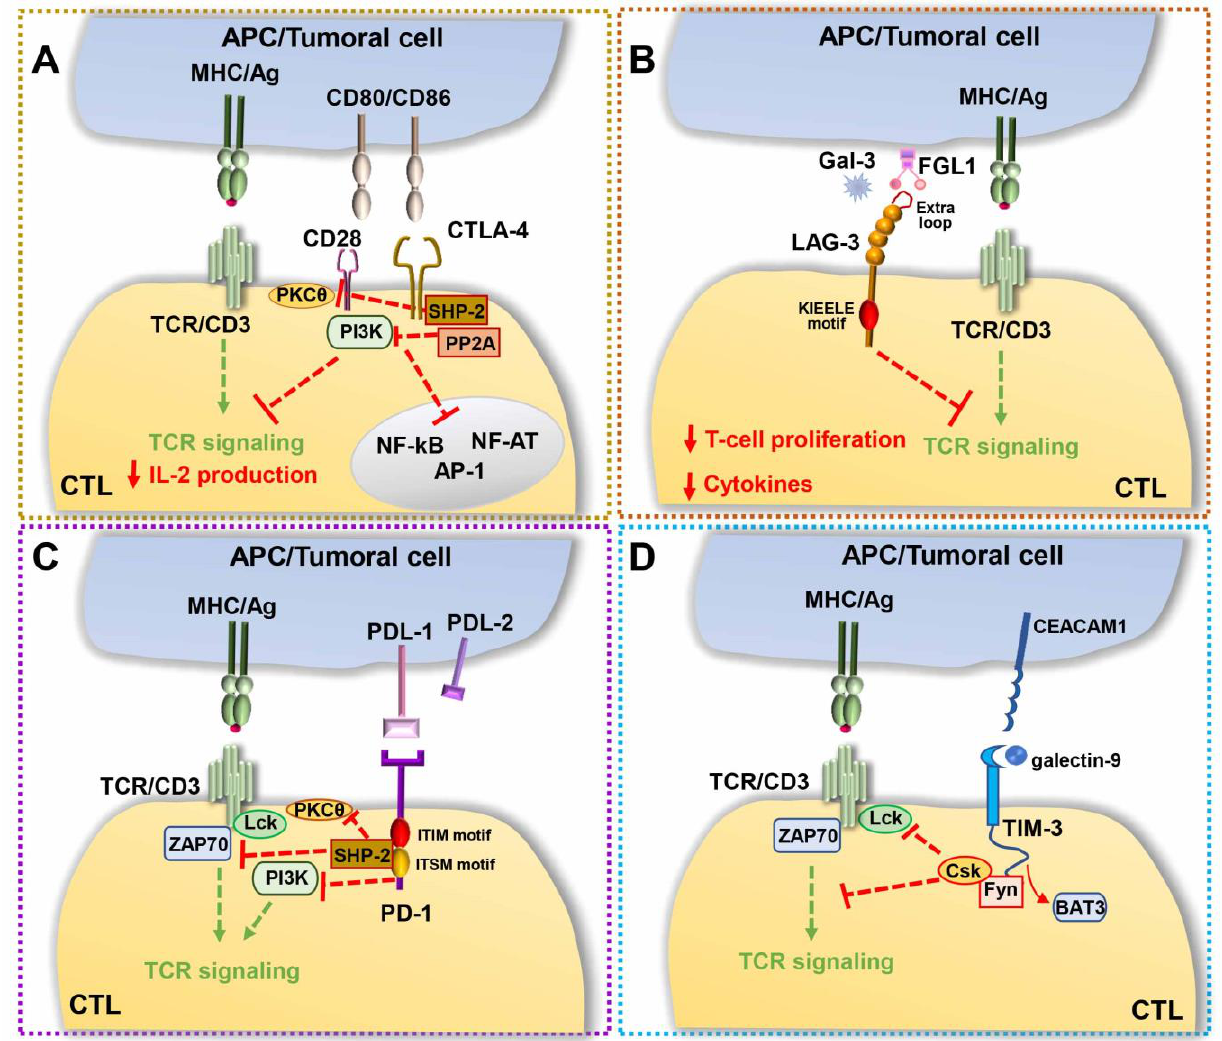
Figure 3. Immune checkpoints. Inhibitory signals triggered by CTLA-4/CD80 (CD86) ( A ), LAG-3/MHCll (or Gal-3 and FGL1) ( B ), PD-1/PD-L1( C ), and TIM-3/Gal-9 ( D ) axes suppress the TCR-dependent signaling pathways, thereby contributing to the balance between self-tolerance and tumor cell clearing. Gal-3, Galectin-3; FGL1, fibrinogen-like protein 1; Gal-9, Galectin-9.